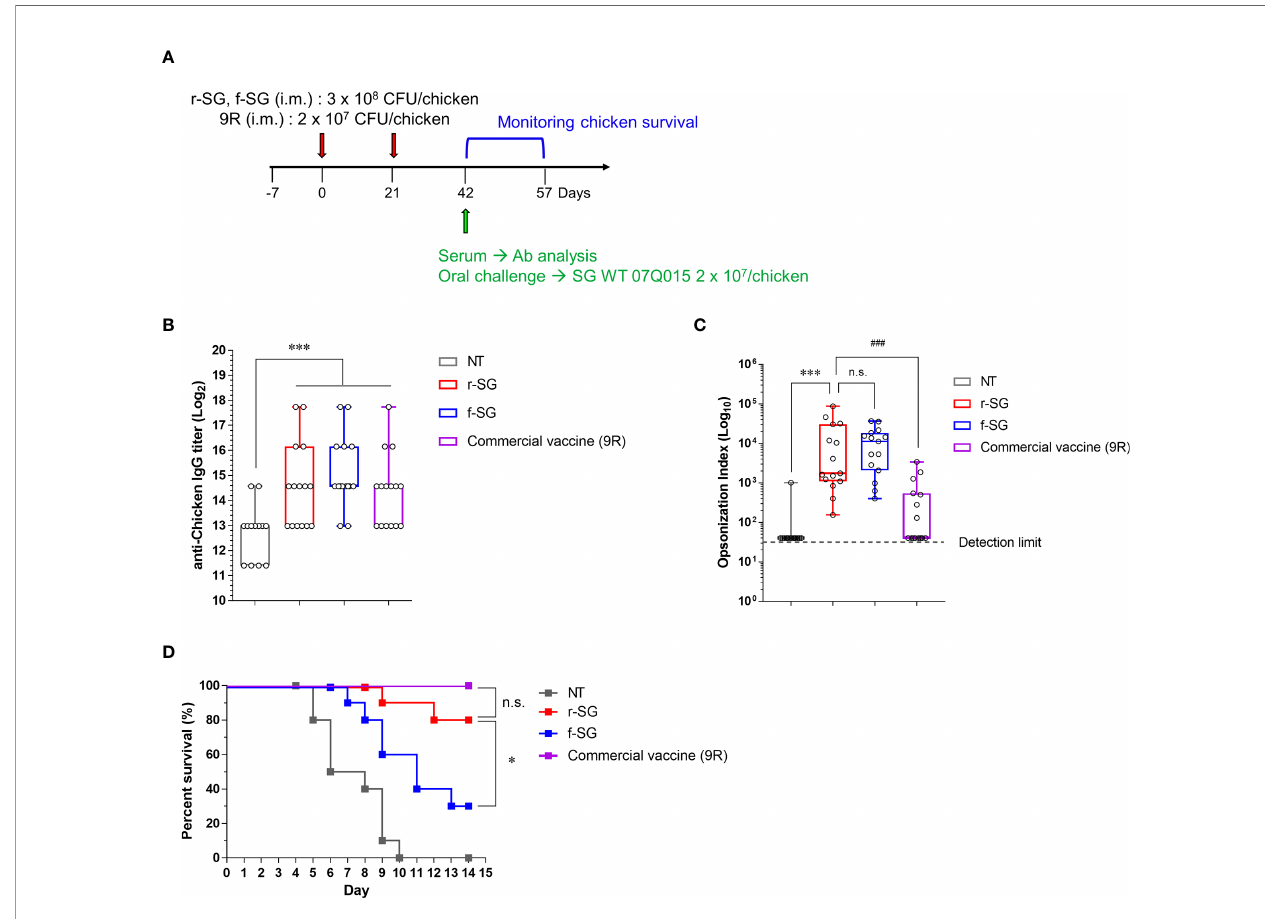
FIGURE 5 | Analysis of humoral immune responses induced by immunization of r-SG or f-SG in chickens. Brown Leghorn chickens (n = 15 per group) were immunized i.m. with the indicated dose of r-SG, f-SG, or live 9R twice at two week intervals. (A) Schematic overview of chicken study design. (B) A box-and- whisker plot with data points of SG-speci fi c chicken IgG in sera were measured by ELISA and (C) Opsonization indices for r-SG, f-SG, and 9R vaccines against S. Gallinarum. (D) At two weeks after the last vaccination, chickens were orally challenged with 2 x 10 9 CFU SG WT and survival was monitored for 14 d. *P < 0.05, ***P < 0.001, n.s., not signi fi cant, compared with unvaccinated chicken. ### P < 0.001, compared with 9R vaccinated